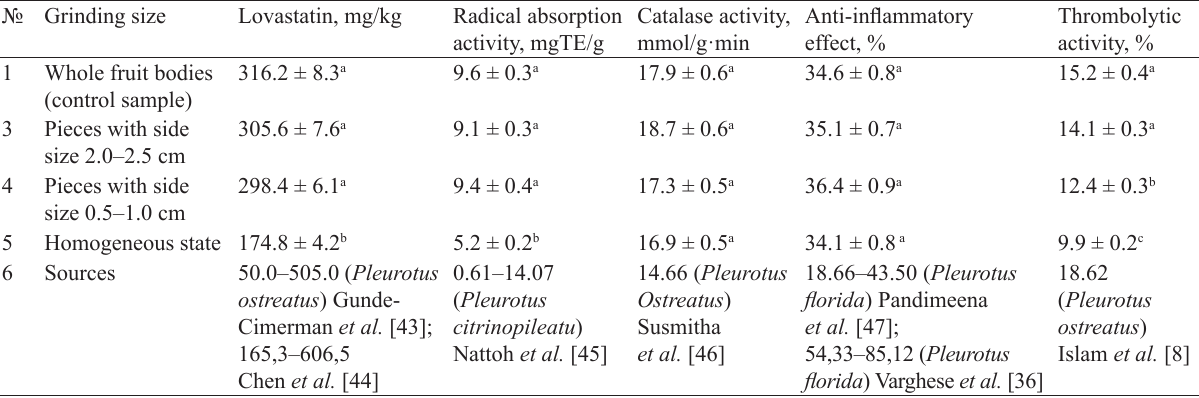
Table 1 Effect of preliminary grinding of oyster mushroom fruit bodies on the bioactive properties of freeze-dried product (M ± m) № Grinding size